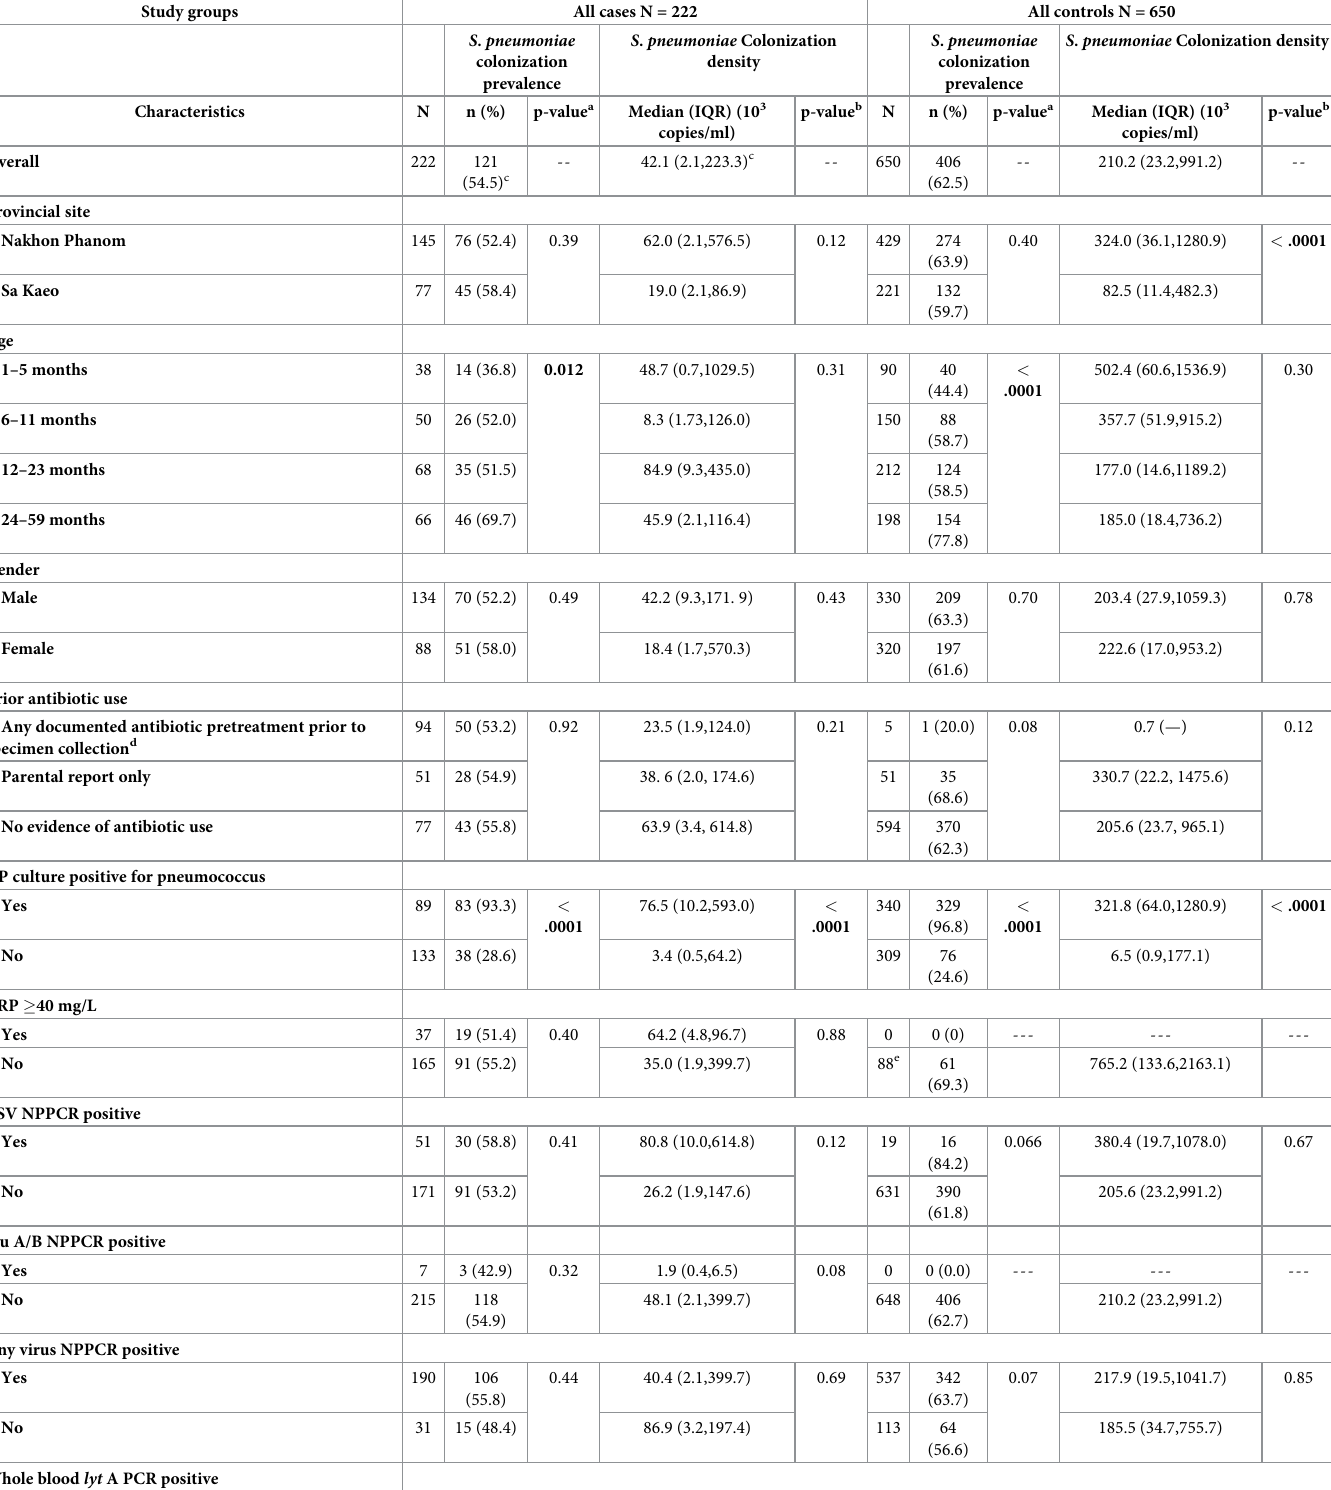
Table 2. Pneumococcal nasopharyngeal PCR positivity and density among positives by case-control group. Study